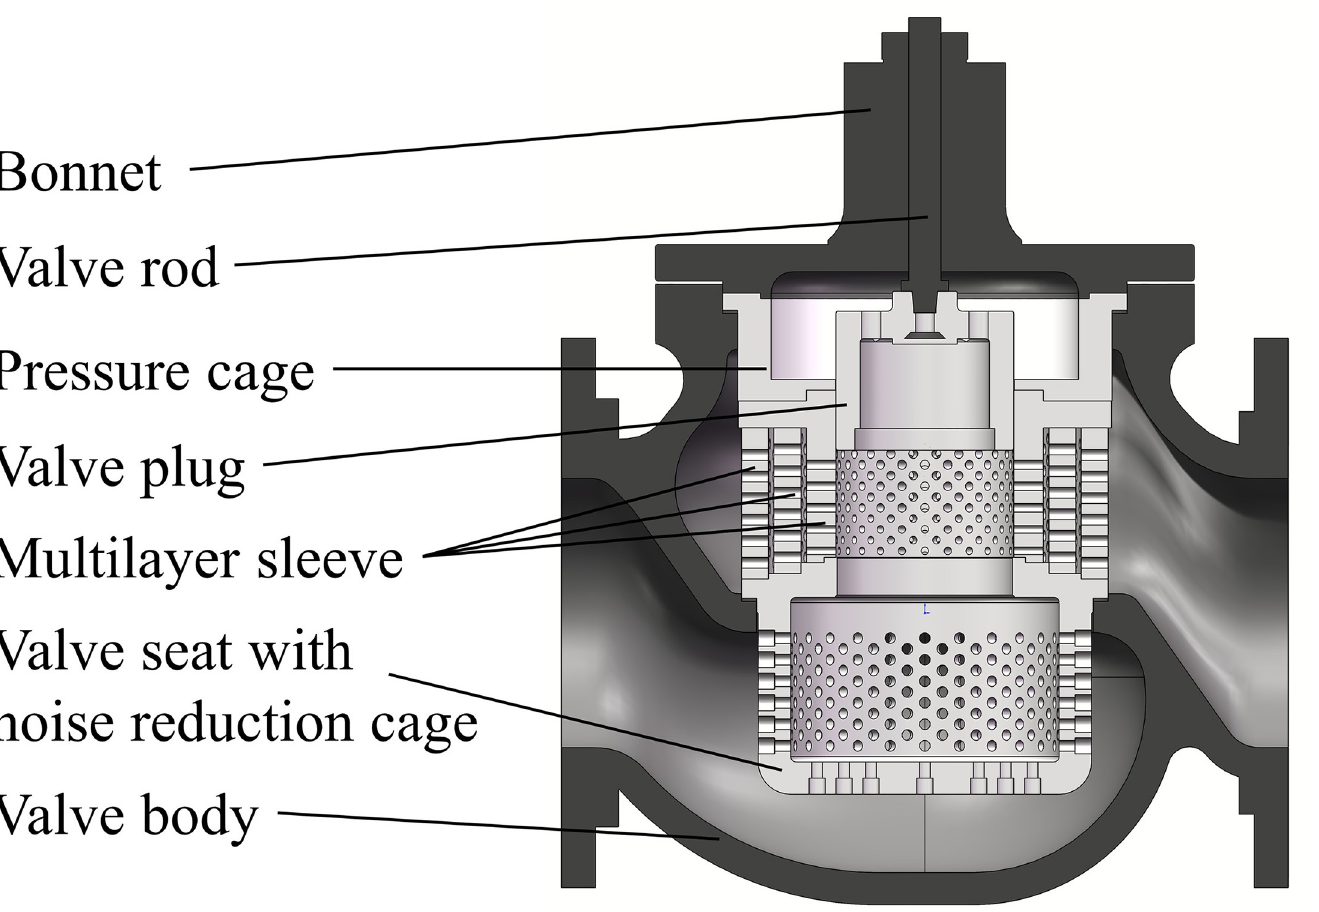
Fig 1. Multistage pressure reducing